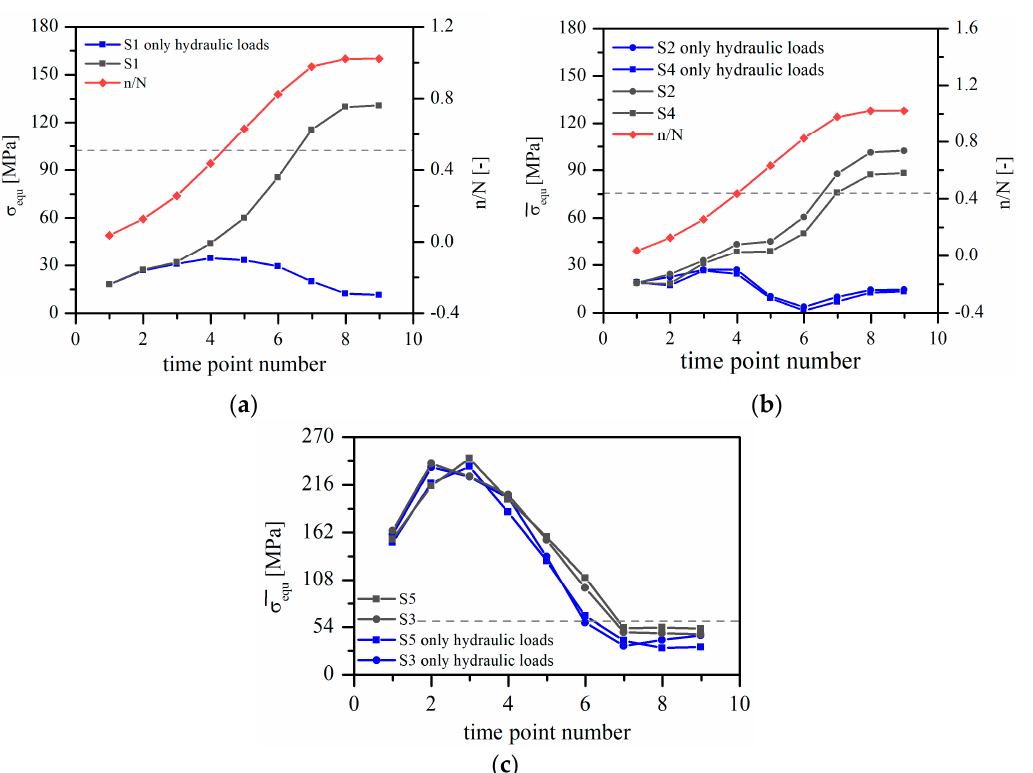
Figure 12. The change of mean stresses in start ‐ up process ( a ) S1; ( b ) S2 and S4; ( c ) S3 and S5.